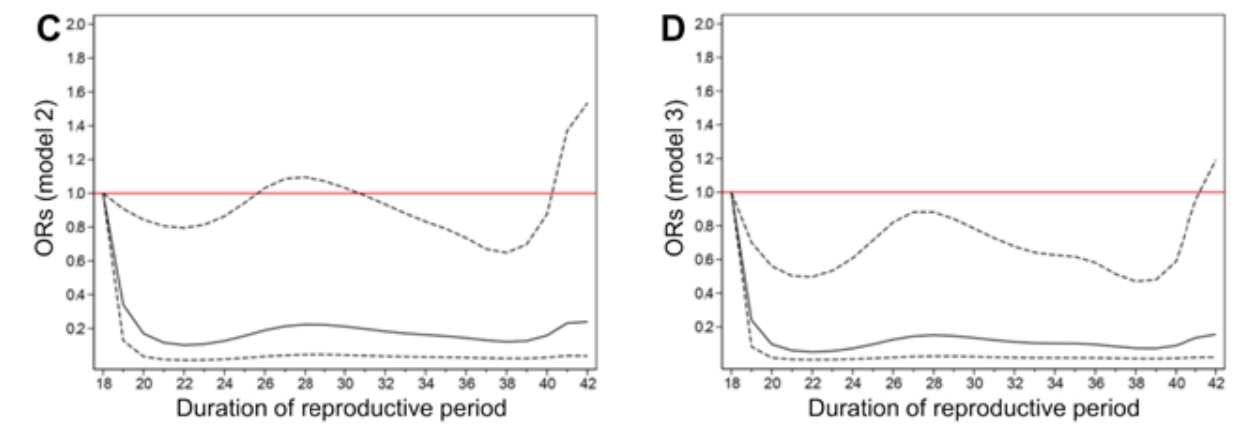
Figure 1. Odds ratios (ORs) (solid line) and 95% confidence intervals (dashed lines) of the reproductive period for estimated glomerular filtration rate (eGFR) < 60 mL/min/1.73 m 2 (reference: 18 years). ( A ) Unadjusted ORs; ( B ) Model 1: adjust for age; ( C ) Model 2: adjust for age, body mass index (BMI), parental history of chronic kidney disease, age at menarche, pregnancies, and hormone replacement therapy; ( D ) model 3: adjust for age, BMI, parental history of chronic kidney disease, age at menarche, pregnancies, hormone replacement therapy, education, smoking, alcohol intake, hypertension, hyperlipidemia, blood urea nitrogen, hemoglobin, albumin, uric acid, and metabolic equivalent.